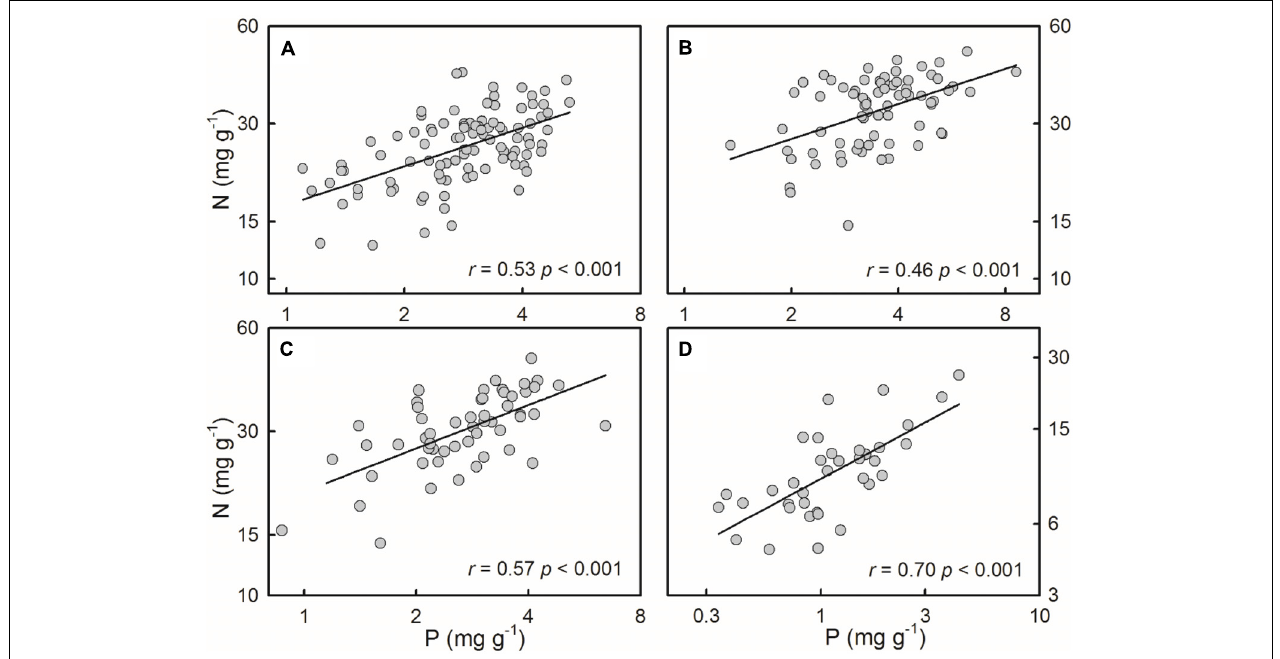
FIGURE 2 | Positive relationships between N and P concentrations of the four species/groups. The correlations were fitted in power functions. (A) S. filiformis , (B) H. tricuspis , (C) T. palustris , and (D) Charophytes. TABLE 2 | The percentage of the total sum of square (%SS) of each explanatory variable in the general linear model.